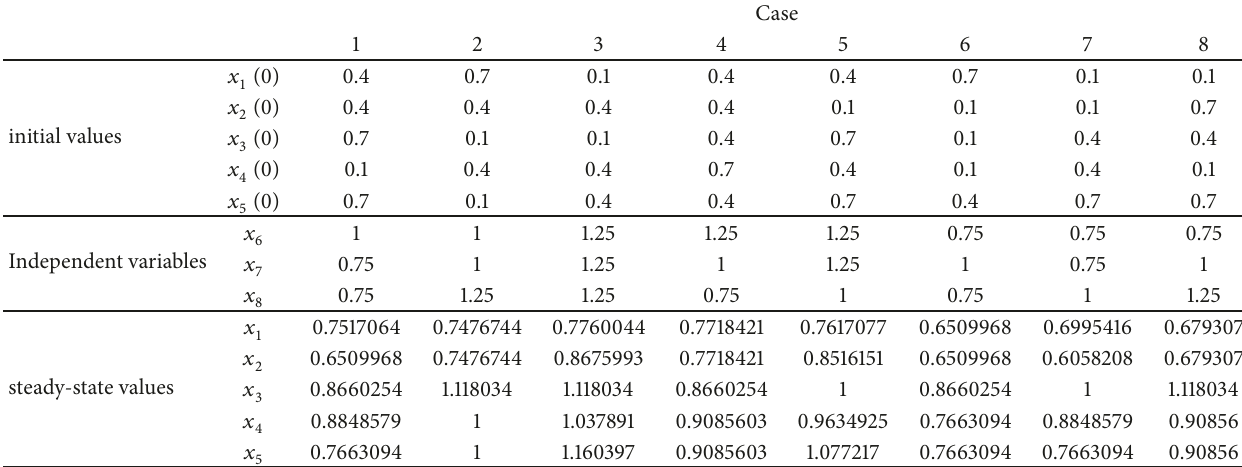
Table 3: Steady state values of the small scale